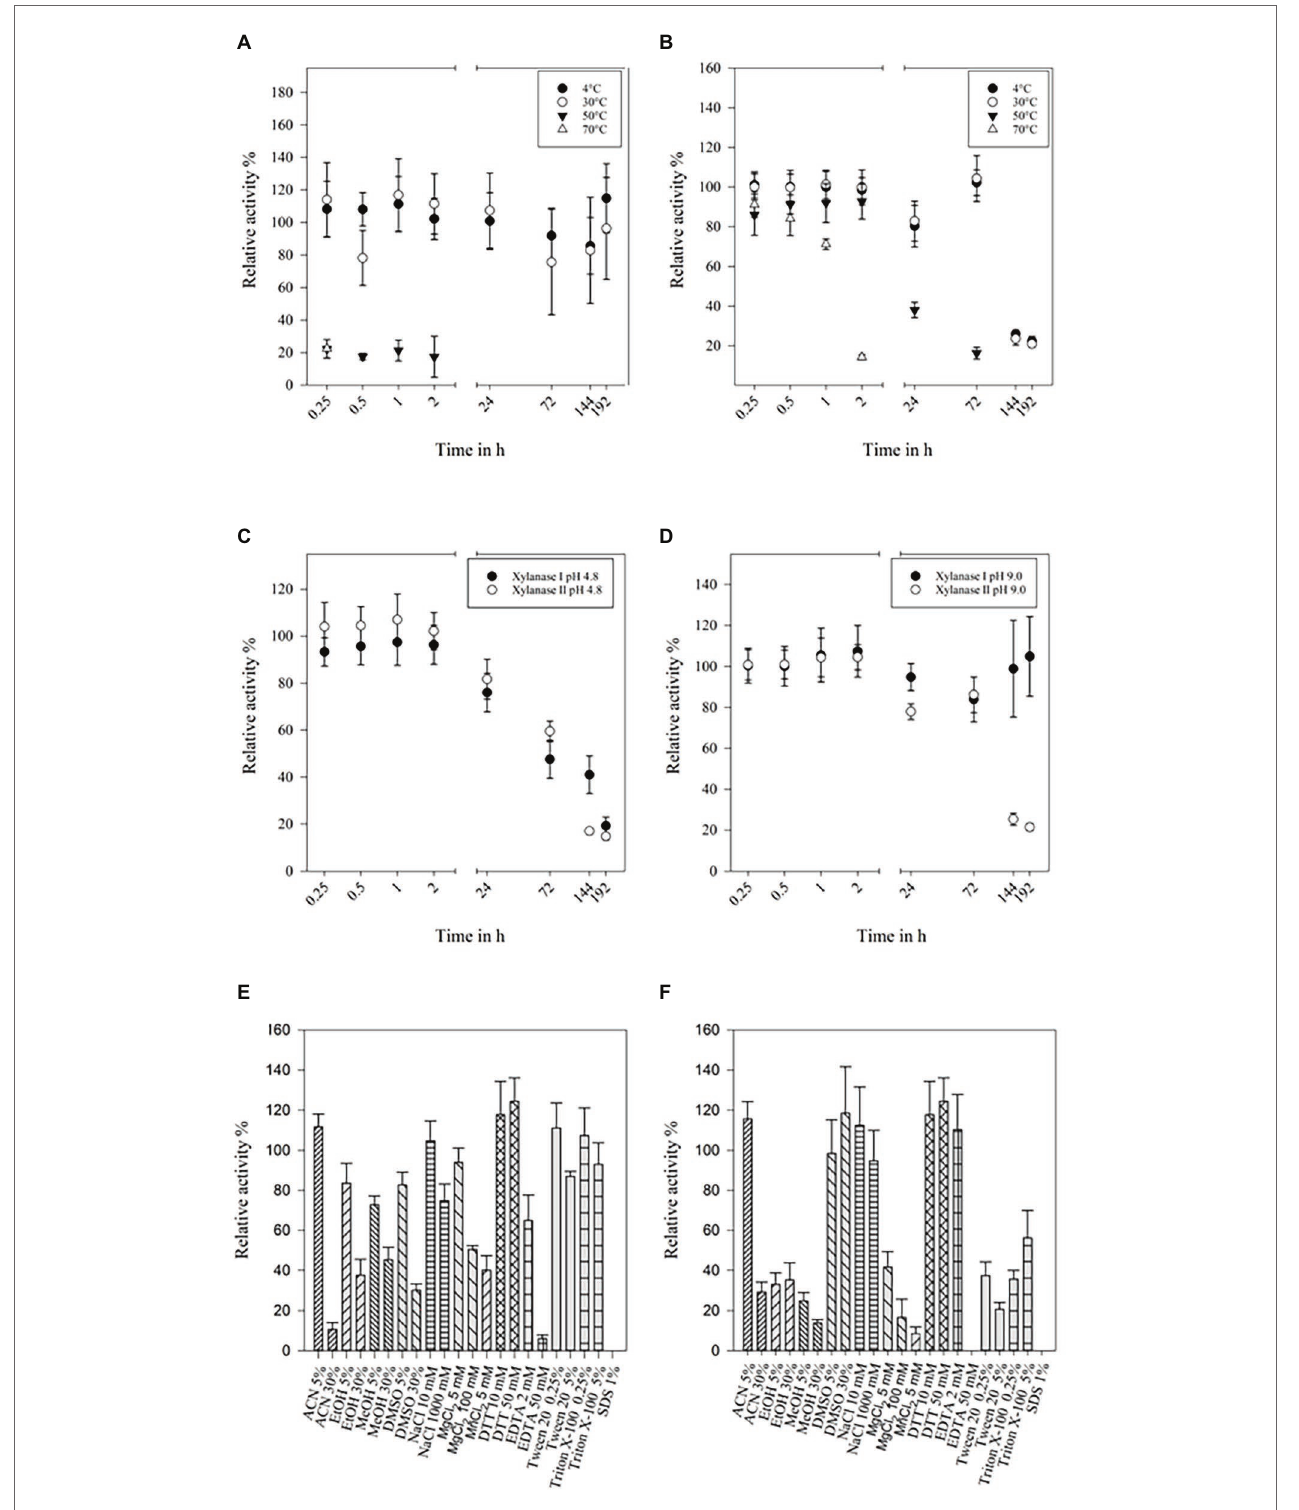
FIGURE 3 | Temperature stability of xylanase I (A) and xylanase II (B) , buffer stability of xylanase I and xylanase II at pH-values 4.8 (C) and 9.0 (D) . (A) Relative activity of xylanase I at 4, 30, 50, and 70 ° C over a time of 192 h with 30 ° C set to 100%, (B) relative activity of xylanase II at 4, 30, 50, and 70 ° C over a time of 192 h with 30 ° C set to 100%, (C) relative activities of xylanase I and xylanase II stored in citrate buffer pH 4.8 at 4 ° C over a time of 192 h with 0.25 h are set to 100%, and